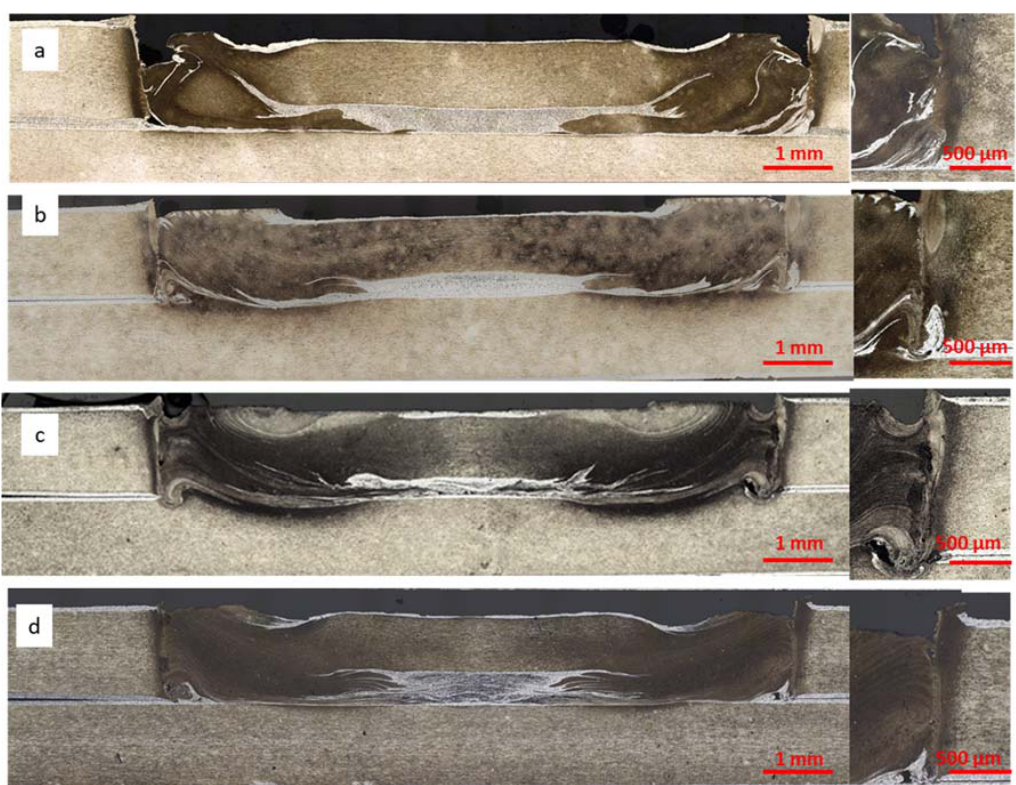
Figure 8. The microstructure of RFSSW made on the plates, with different surface preparation: ( a ) degreasing before welding, ( b ) anodizing before welding, ( c ) anodizing and application of sealant 1 on the overlap surface before welding, ( d ) anodizing and application of sealant 2 on the overlap surface before welding . before